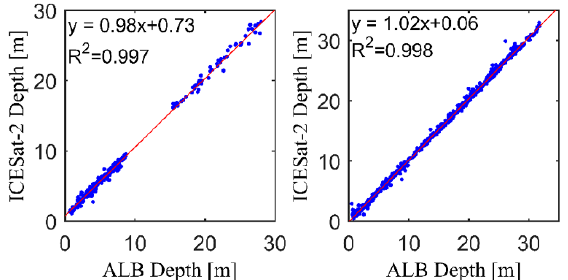
Figure 13. Comparison of ICESat-2 bathymetry and airborne LiDAR bathymetry data from the sampling area of Oahu ( Left ) and St. Thomas ( Right ). Table 1. Validation of ICESat-2 bathymetry results in Oahu area.